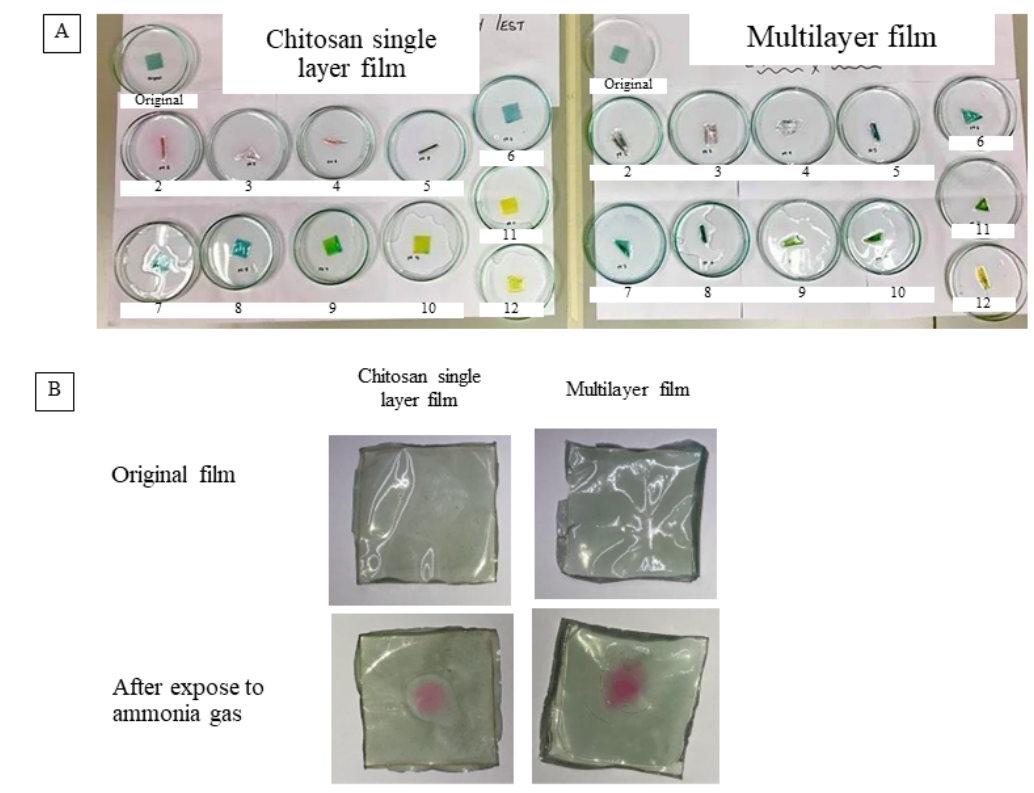
Figure 3. pH sensitivity (( A ) numbers in each figure are pH value) and gas sensitivity ( B ) of the monolayer chitosan film vs. multi-layered films.